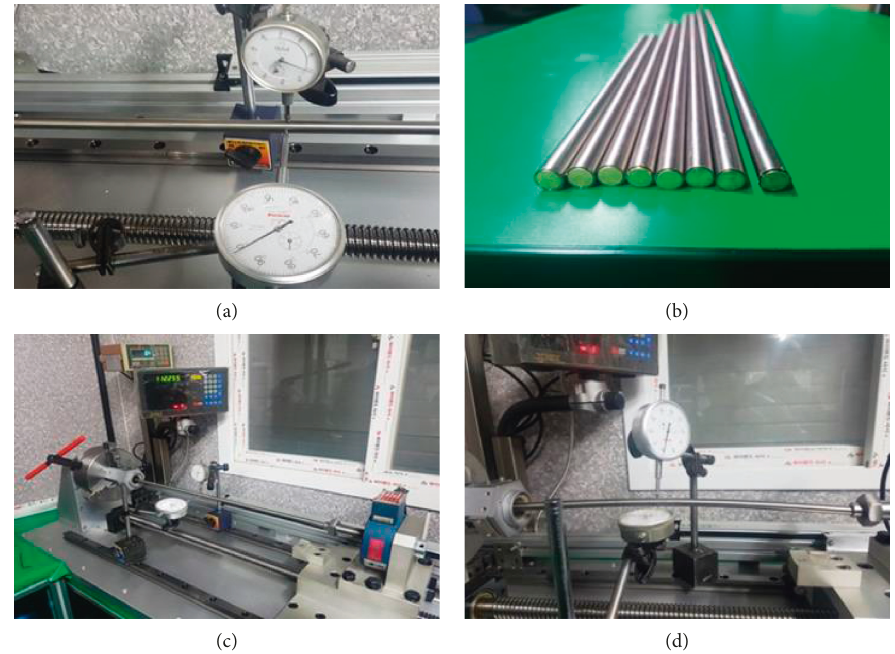
Figure 10: Buckling test according to Zry-4 tube lengths: (a) rod-cuts, (b) instrument, (c) measurement, and (d)